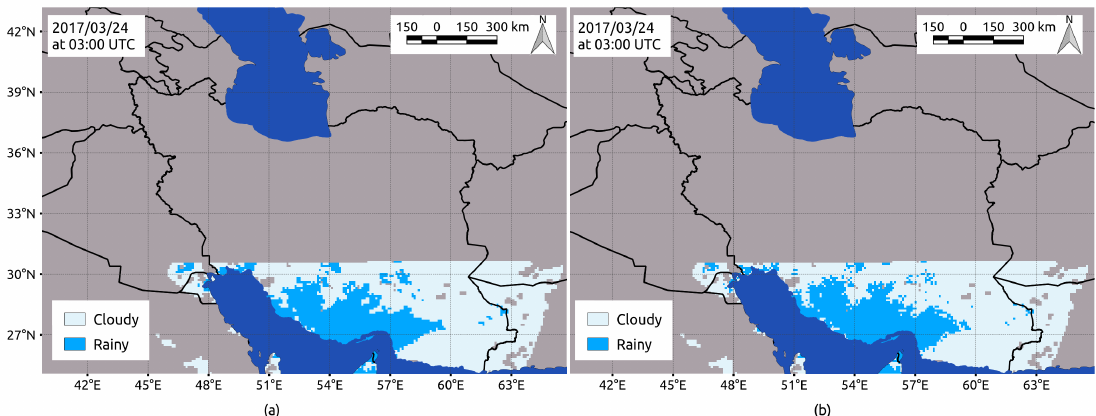
Figure 7. Sample satellite scene from 24 March 2017 03:00 UTC. The rainfall area from ( a ) microwave- based IMERG as well as corresponding ( b ) RF classification results. The pixels were selected only where the microwave IMERG was available.